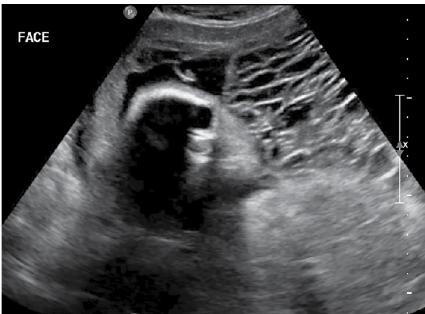
Figure 1: Ultrasound appearance of the fetus next to the molar component of the pregnancy at 26 weeks.